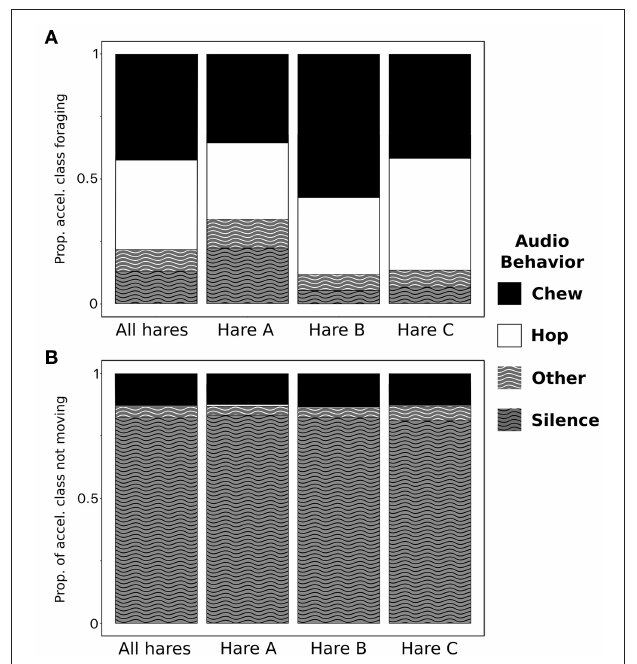
FIGURE 5 | Acoustic determination of time spent chewing (black), hopping (white), silent (black stripe), and other (white stripe) during accelerometer-defined bouts of foraging (A) and not moving (B) , across all individuals ( n = 3) and for each individual free-ranging snowshoe hare.